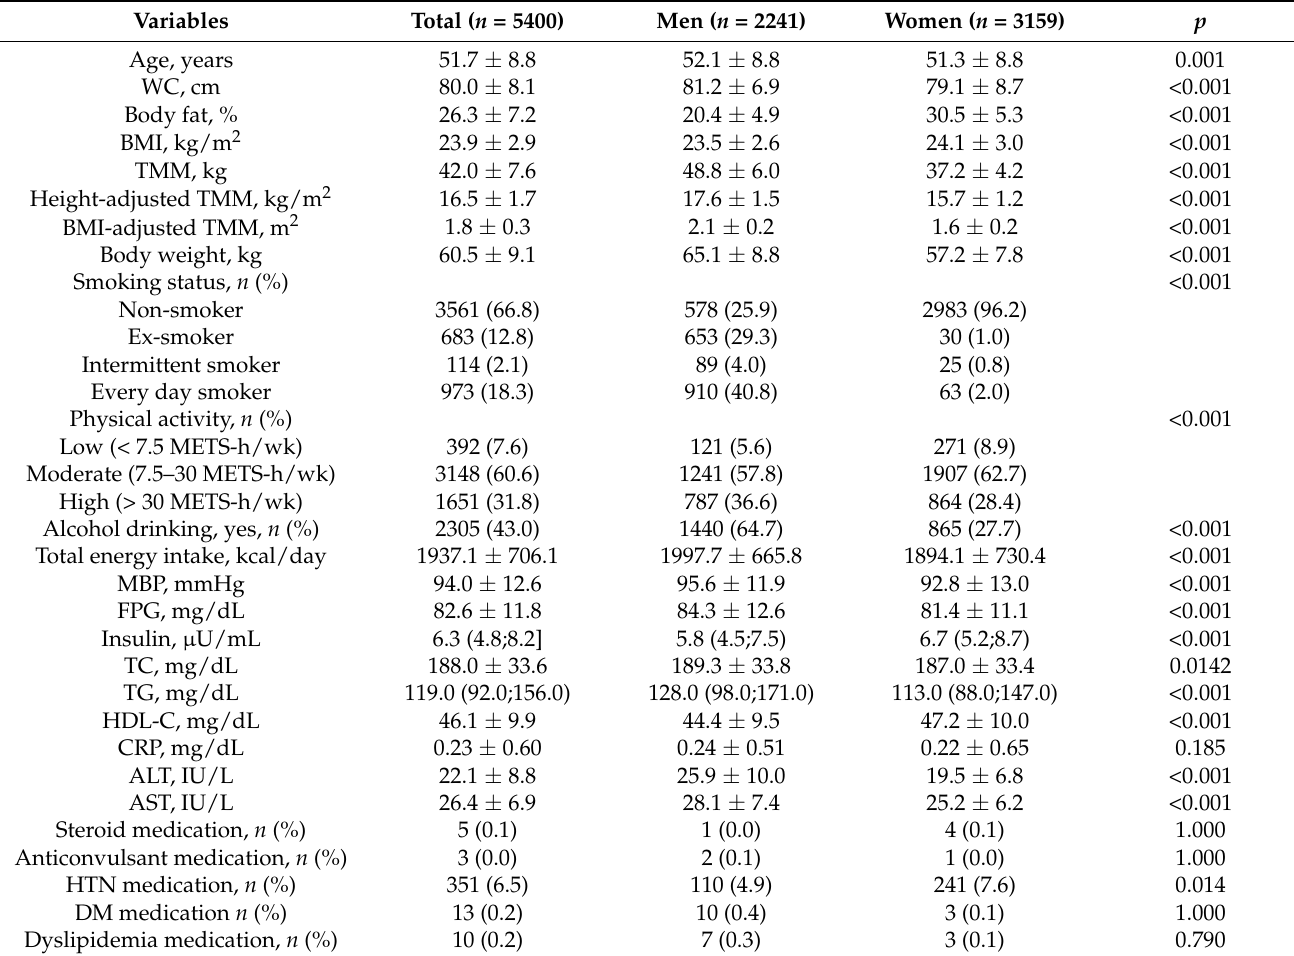
Table 1. Baseline characteristic of the study